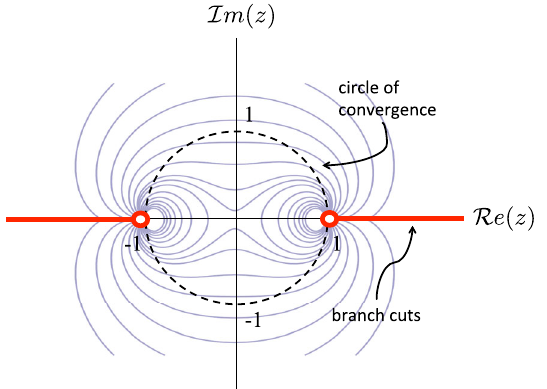
FIG. 1. Domain of analyticity of the complex function F , which defines the vector potential of the nonlinear insert in the trans- verse plane. The curves in blue denote magnetic field lines. The dashed circle denotes the circle of convergence of the multipole series. Singularities occur at the points z ¼ (cid:4) 1